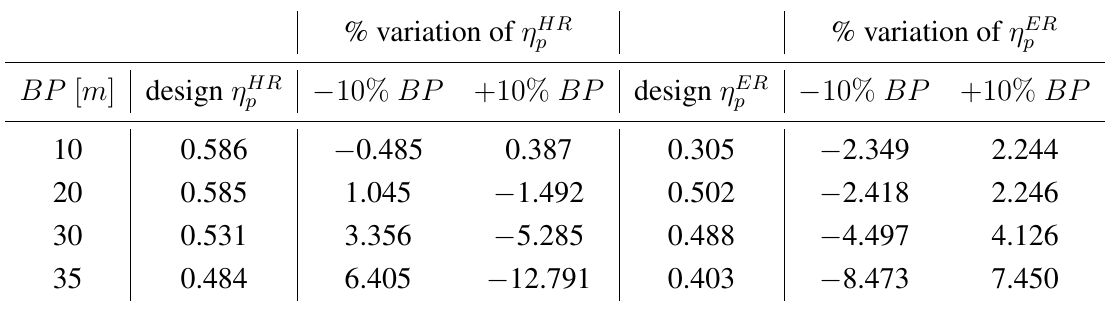
Table 3. Flexibility of the hydropower plant—comparison between HR mode and ER